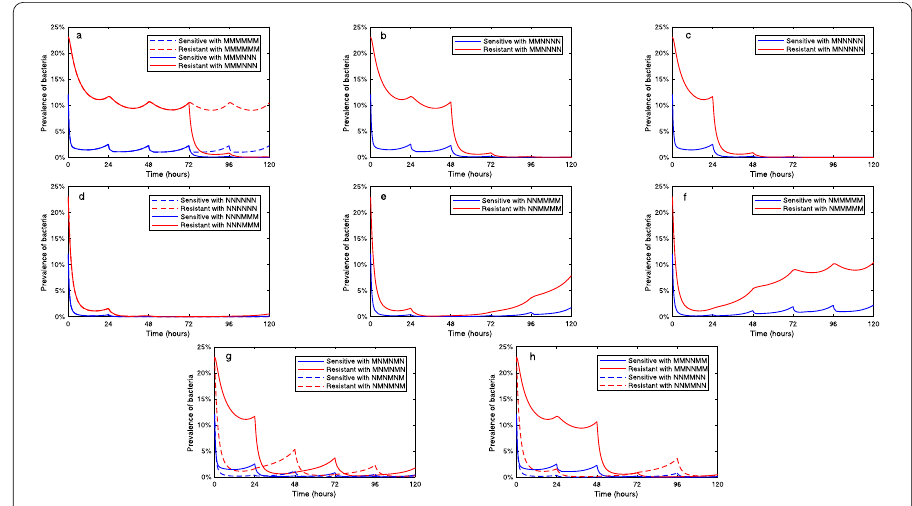
Figure 7 Switchingofantibioticagents . ( a ) Prevalence of sensitive and resistant bacteria with exposure to the antibiotic M: without and with introduction of the antibiotic N (dashed line for administration of the antibiotic M only and solid line for administration of three doses of the antibiotic M followed by three doses of the antibiotic N. ( b ) & ( c ) Prevalence of sensitive and resistant bacteria with administration of two doses of the antibiotic M and four doses of the antibiotic N and with administration of one dose of the antibiotic M and four doses of the antibiotic N, respectively. ( d ) Prevalence of sensitive and resistant bacteria with exposure to the antibiotic N: without and with introduction of the antibiotic M (dashed line for administration of the antibiotic N only and solid line for administration of three doses of the antibiotic N followed by three doses of the antibiotic M. ( e ) & ( f ) Prevalence of sensitive and resistant bacteria with administration of two doses of the antibiotic N and four doses of the antibiotic M and with administration of one dose of the antibiotic N and four doses of the antibiotic M, respectively. ( g ) Prevalence of sensitive and resistant bacteria according to antibiotic switching between M and N starting with M (solid line) and N (dashed line). ( h ) Prevalence of sensitive and resistant bacteria switched between two doses of M and two doses of N starting with with M (solid line) and N (dashed line). ( S (0) = 1.2 × 10 8 and R (0) = 2.3 × 10 8